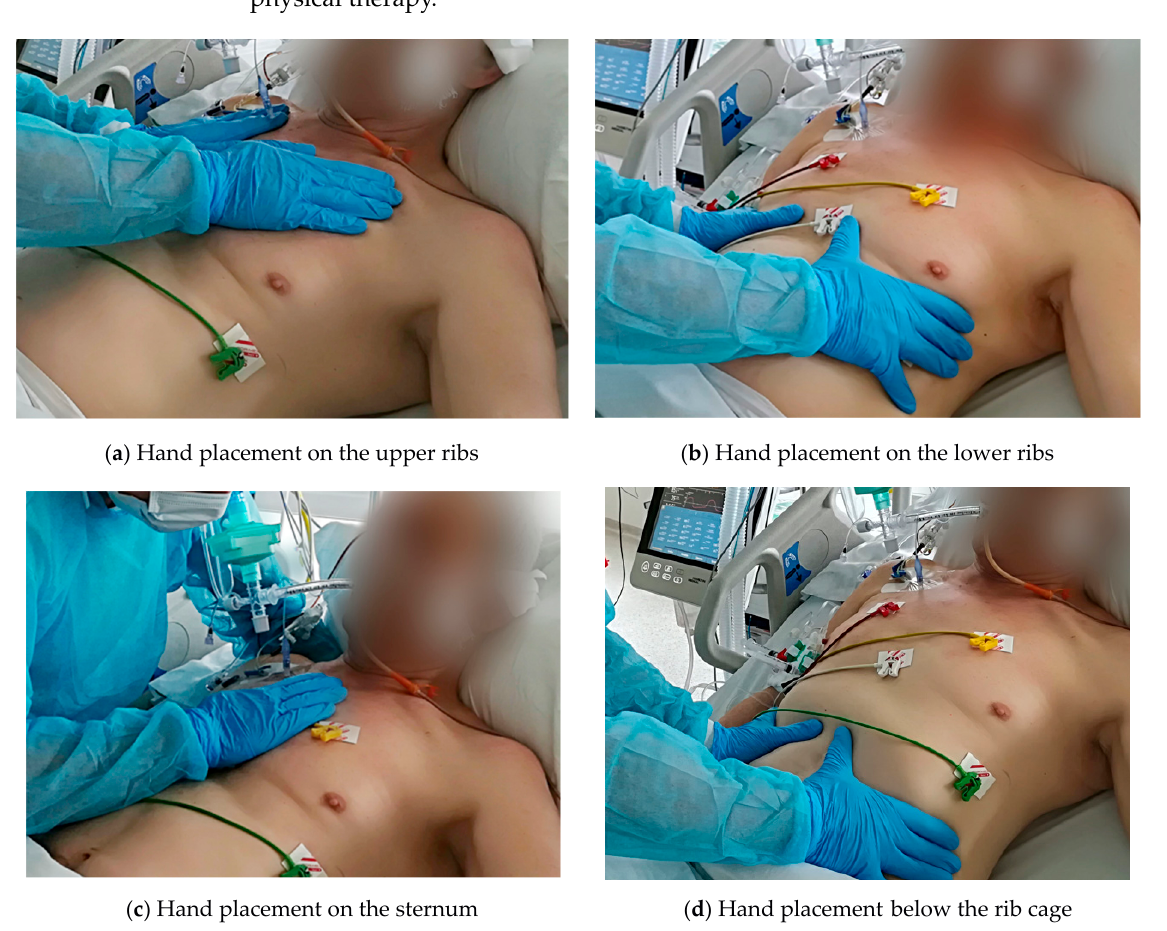
Figure 2. ( a – d ) Hand placement during breathing stimulation for both the RIT and IST. RIT = rhythmic initiation technique, IST = initial stretch technique.